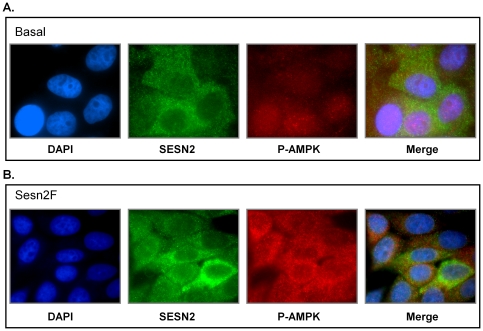
SESN2 is found in close proximity with active AMPK in the cytoplasm of MCF7 cells.(A) Untreated MCF7 cells were fixed and stained with DAPI (blue), SESN2 (green), or P-AMPKα (red). (B) MCF7 cells were transfected with 1 µg Sesn2F vector (Sesn2F) for 24 h, followed by fixation and staining with DAPI (blue), SESN2 (green), or P-AMPK (red). The cells were then imaged at 40× and merged images are displayed on the right. Representative images from 3 independent experiments are shown.